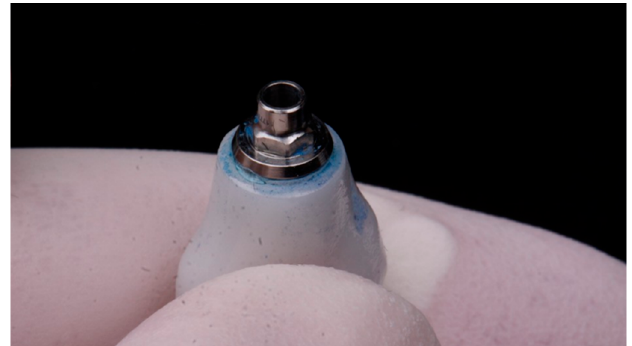
Figure 8. Over ‐ contour profile of the restoration and the excess of the cement are visible from the significant accumulation of blue dye in that area.